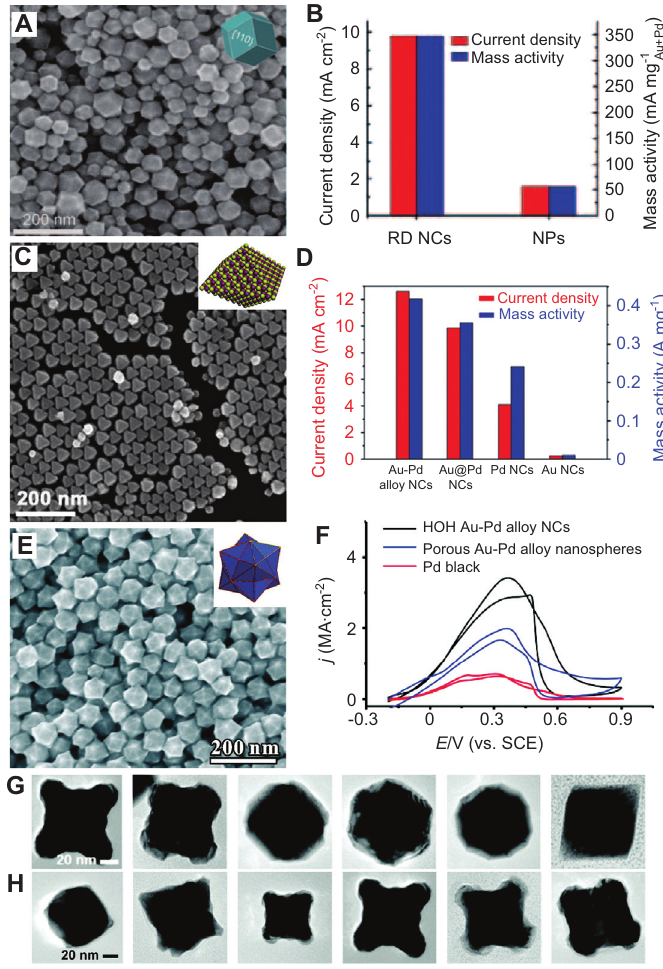
Figure 11 (A–B) Au-Pd alloy rhombic dodecahedra (RDs) and specific activities for EOR. Adapted with permission from Ref. [69]. Copyright 2011 Wiley. (C–D) Au-Pd alloy octahedra and specific activities for FOR. Adapted with permission from Ref. [12]. Copyright 2011 Wiley. (E–F) Au-Pd alloy hexoctahedra and CVs for FOR. Adapted with permission from Ref. [74]. Copyright 2011 American Chemical Society. (G–H) Au-Pd nanocrystals formed with decreasing pH and increasing Pd precursor, respectively. Adapted with permission from Ref. [68]. Copyright 2012 American Chemical